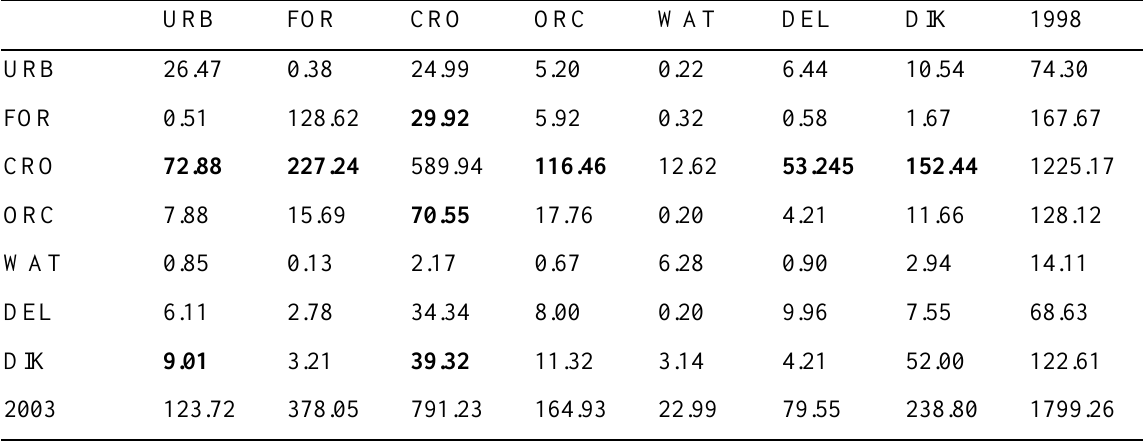
Table 3. Land use change matrix in Huadu from 1998 to 2003 (km 2 ). URB FOR